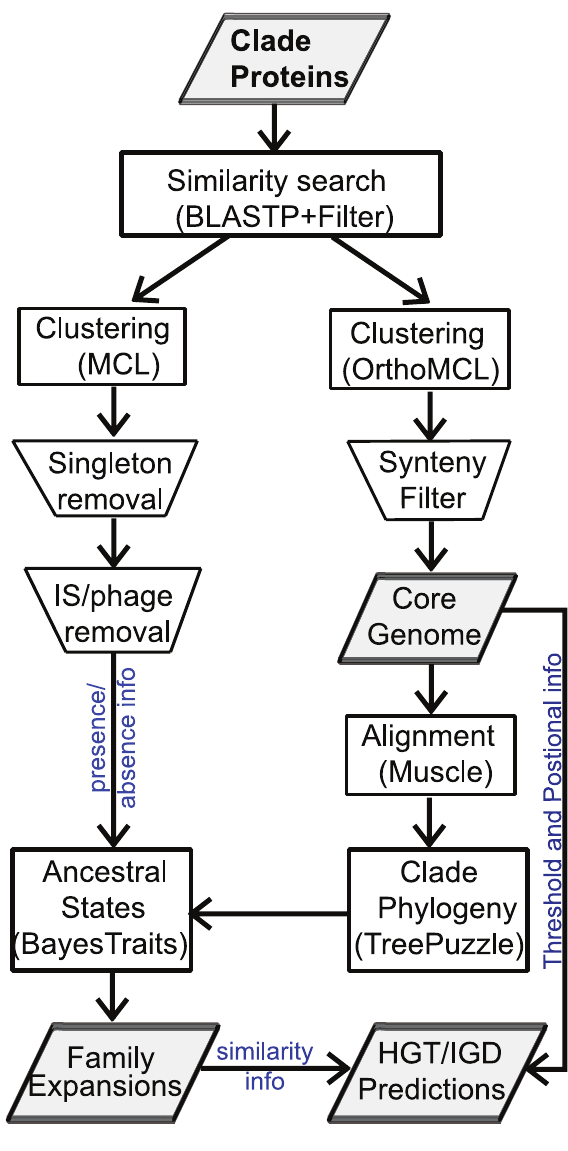
Figure 6. Protein family construction pipeline. Starting with a databank of proteins, we first performed all pairwise similarity searches using BLASTP. The hits were filtered regarding the length of the match (70% of the length of the query) and the bitscore (30% of the maximal bitscore calculated by aligning a protein against itself). To build the gene families we ran MCL blastline and then removed all singletons, IS and Phage. To build the core genome we used OrthoMCL along with a synteny filter based on M-GCAT Clusters. Finally, using presence/ absence and phylogenetic information, we obtained the protein families with